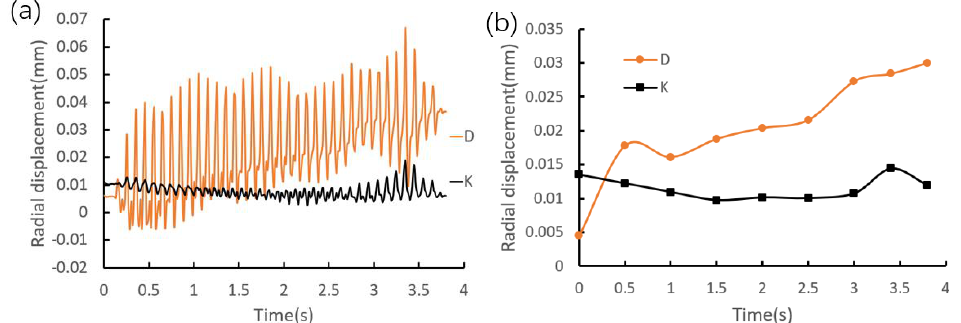
Figure 15. Radial displacement distributions at point D and point K. ( a ) Global change. ( b ) Fitting value change.